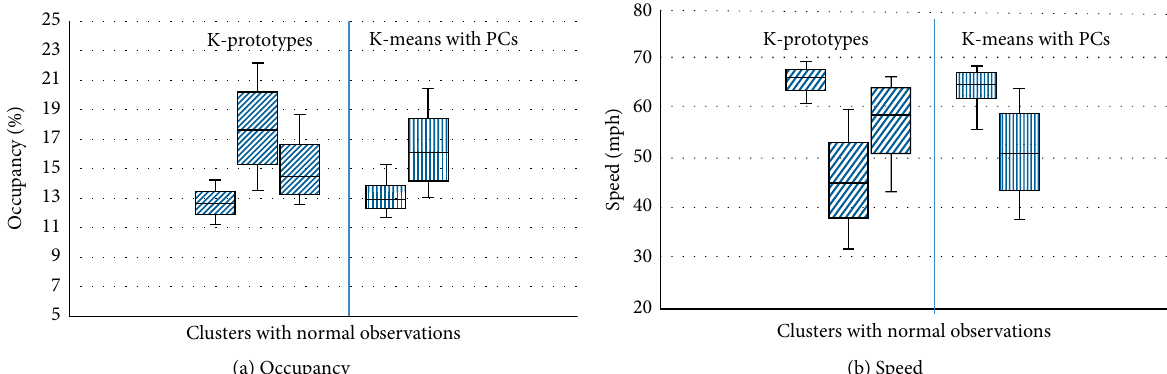
Figure 12: Variation of occupancy and speed within the clusters identified by the clustering methods for normal